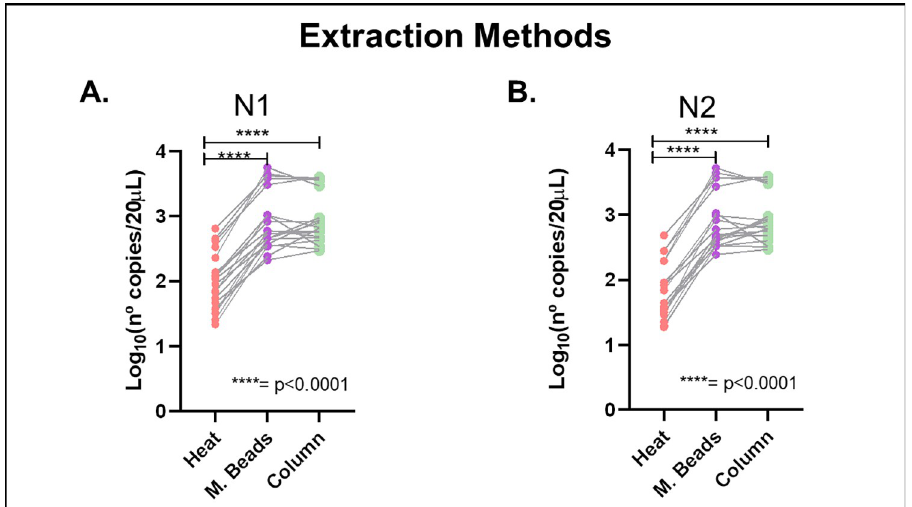
Fig 2. Different methods of extraction assay. N˚ copies/20 μ L obtained with different methods of extraction (heat, manual by column and automated method by magnetic beads) for A) N1 and B) N2 sequences of the N gene of SARS-CoV-2. The Wilcoxon test and Friedman’s tests for paired, non-parametric samples determined that there is significant difference (p < 0.0001) between heat extraction method and the other two methods. https://doi.org/10.1371/journal.pone.0271860.g002 Cross contamination assessment. To assess the possibility of cross-contamination throughout the process, 20 negative pools were seeded alternated in a plate with 20 pools spiked with a positive sample. Considering the European pharmacopeia [29] specifications, this positive sample had to be present at a viral load concentration 2 order of magnitude higher than the concentration used for the maximum pool. Therefore, since CT = 30 is the highest